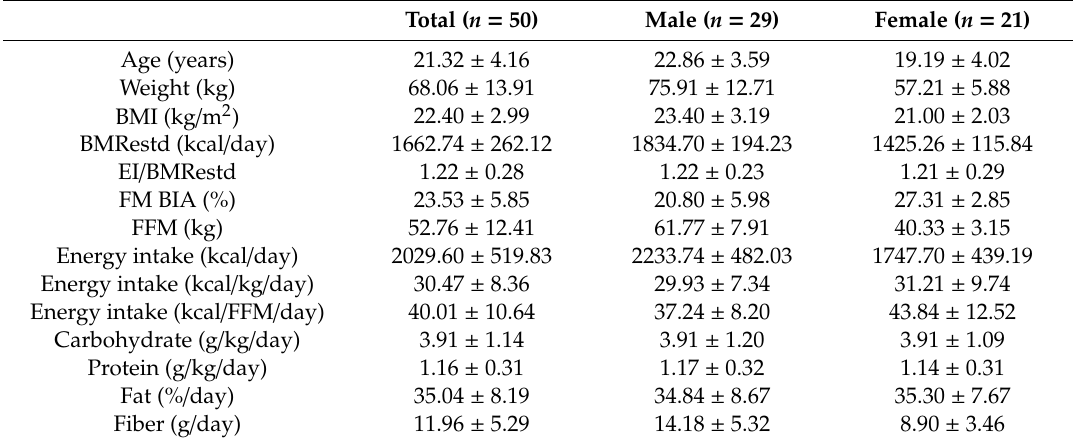
Table 1. Anthropometric, body composition characteristics and mean daily nutrient intake of the sample population (Mean ±